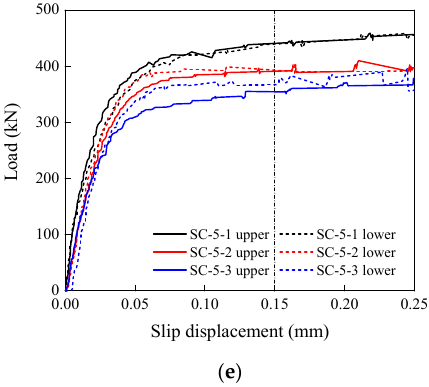
Figure 6. Typical load–displacement curves of slip factor tests. ( a ) Polishing. ( b ) Brushing. ( c ) Grit blasting. ( d ) Shot blasting. ( e ) Grit blasting–HVOF coating.